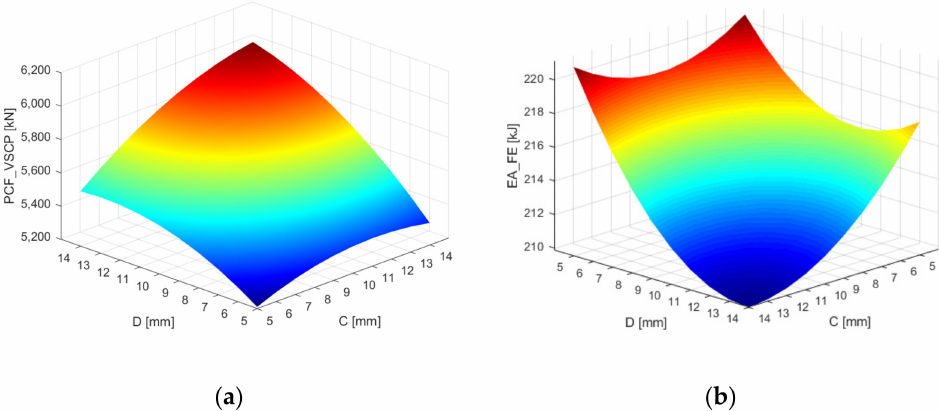
Figure 18. Response surface: ( a ) response surface of PCF_VSCP with parameters C and D; ( b ) re- sponse surface of EA_FE with parameters C and D.